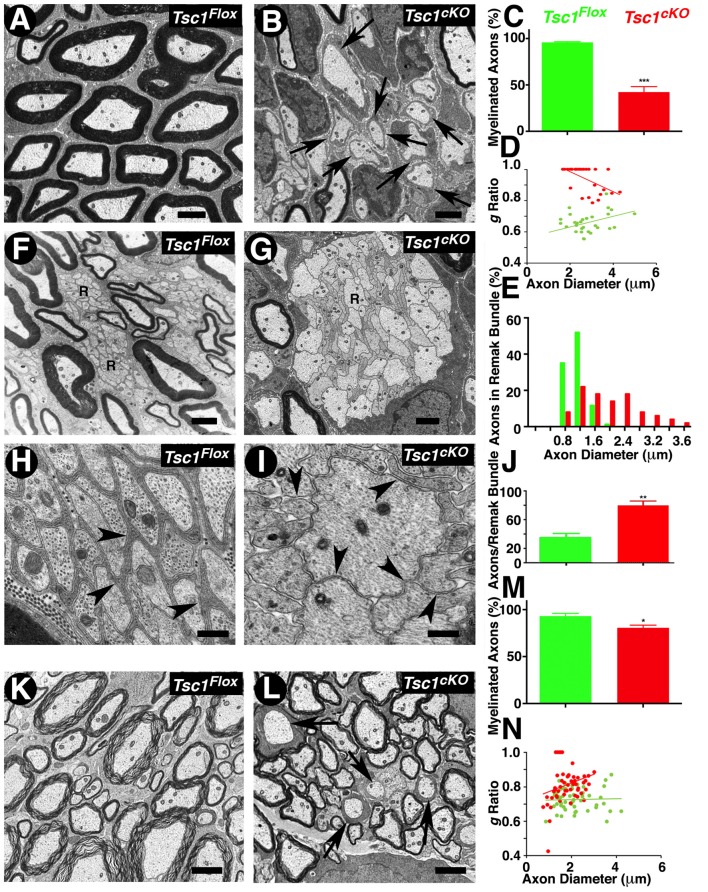
Ultrastructural analysis reveals severely hypomyelinated axons and disorganized peripheral nerve remak bundles. (A–D) Transmission electron microscopy (TEM) of cross sections from the sciatic nerve of P15 Tsc1Flox
(A) and Tsc1cKO
(B) mice. Morphometric analysis of myelinated axons in sciatic nerves, showing the percentage of myelinated axons (C) and the g-ratio values (D). (F–J) TEM of cross sections, focusing on Remak bundles from sciatic nerve of P15 Tsc1Flox
(F,H) and Tsc1cKO
(G,I) mice. Axon diameter distribution and the number of axons per Remak bundle are shown in (E,J), respectively. (K–N) TEM of cross sections from SC of P15 Tsc1Flox
(K) and Tsc1cKO
(L) mice. Morphometric analysis of myelinated axons in the SC showing the percentage of myelinated axons (M) and the g-ratio values (N). Scale bars: (A,B,K,L) = 2 μm; (F,G) = 1 μm; (H,I) = 0.4 μm, *p < 0.05, **p < 0.01 or ***p < 0.001.